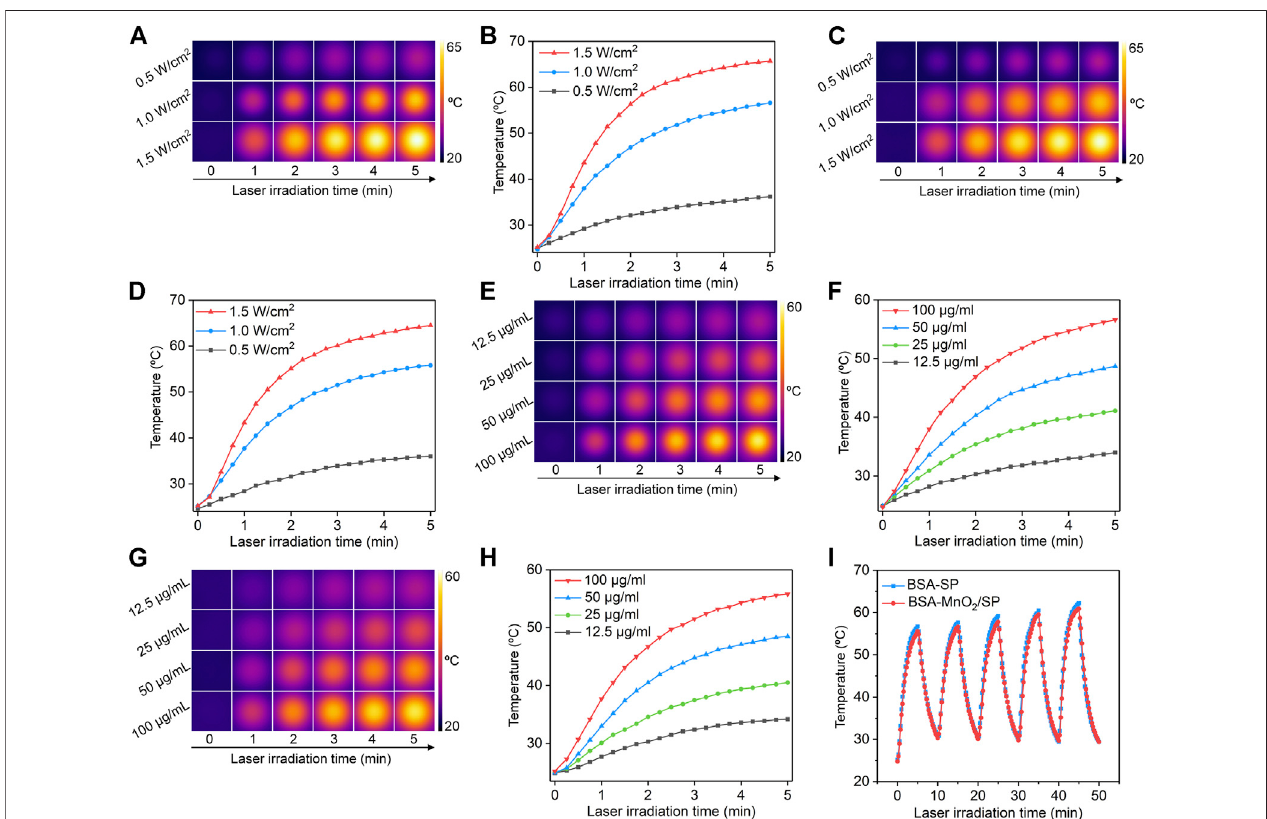
FIGURE 3 | Evaluation of photothermal conversion ef fi cacy. (A) Thermal imaging of solutions containing BSA-MnO 2 /SP nanocomposites under 808 nm laser irradiation at power densities of 0.5, 1.0, and 1.5 W/cm 2 . (B) Temperature curves of BSA-MnO 2 /SP nanocomposite solution under 808 nm laser irradiation at different power densities. (C) Thermal imaging of solutions containing BSA/SP nanoparticles under 808 nm laser irradiation at power densities of 0.5, 1.0, and 1.5 W/cm 2 . (D) Temperature curves of BSA/SP nanoparticle solution under 808 nm laser irradiation at different power densities. (E) Thermal imaging of solutions containing BSA- MnO 2 /SP nanocomposites at concentrations of12.5, 25,50, and 100 μ g/ml under808 nm laserirradiation at apower density of1.0 W/cm 2 . (F) Temperature curves of